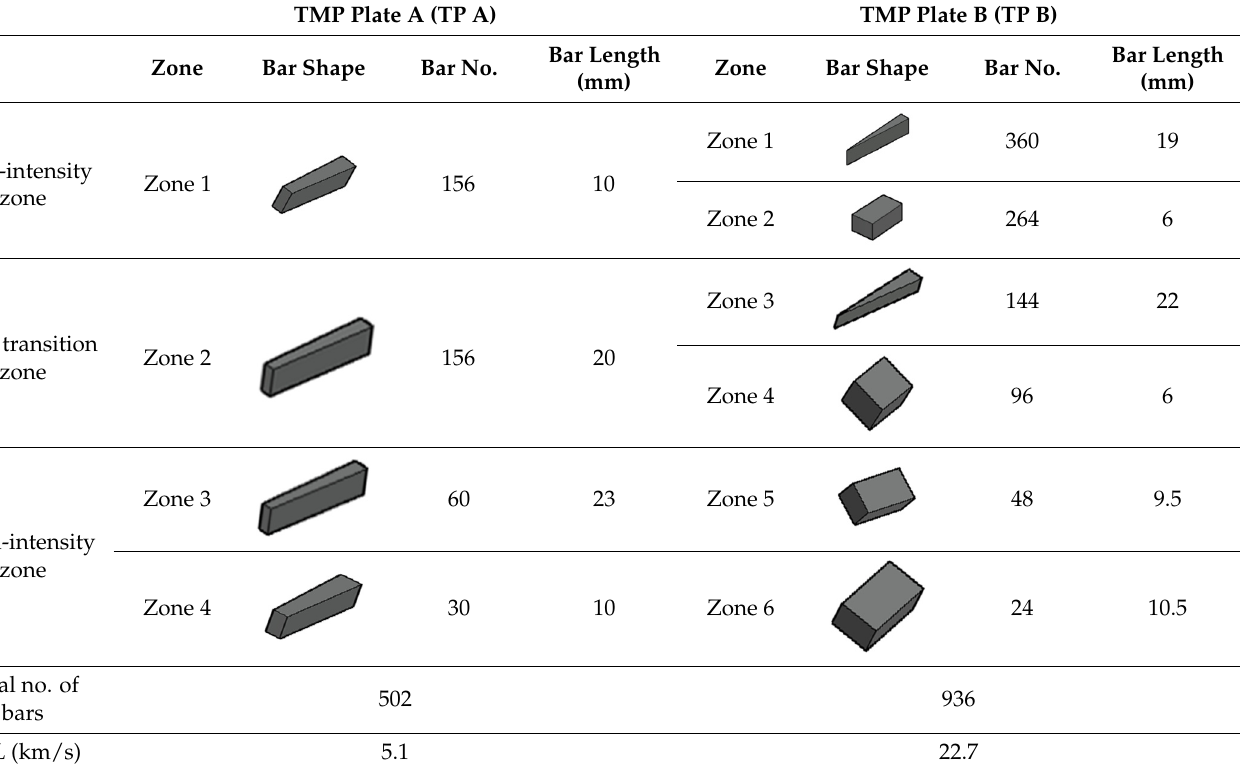
Table 5. CEL calculation of two plates with different patterns.